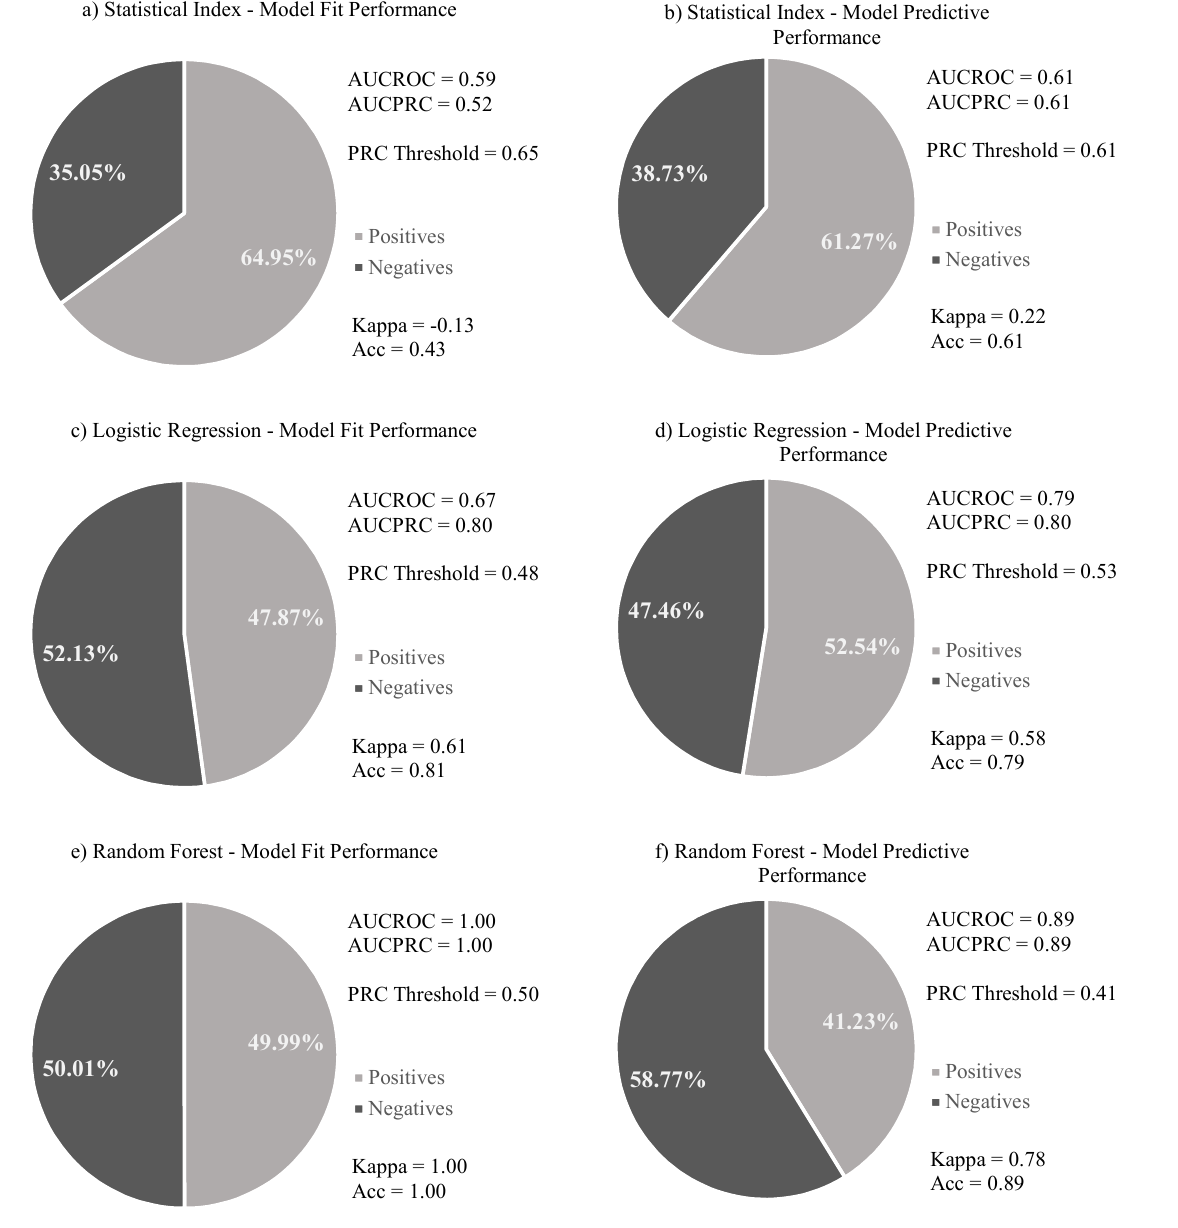
Figure 7. Summary of the model